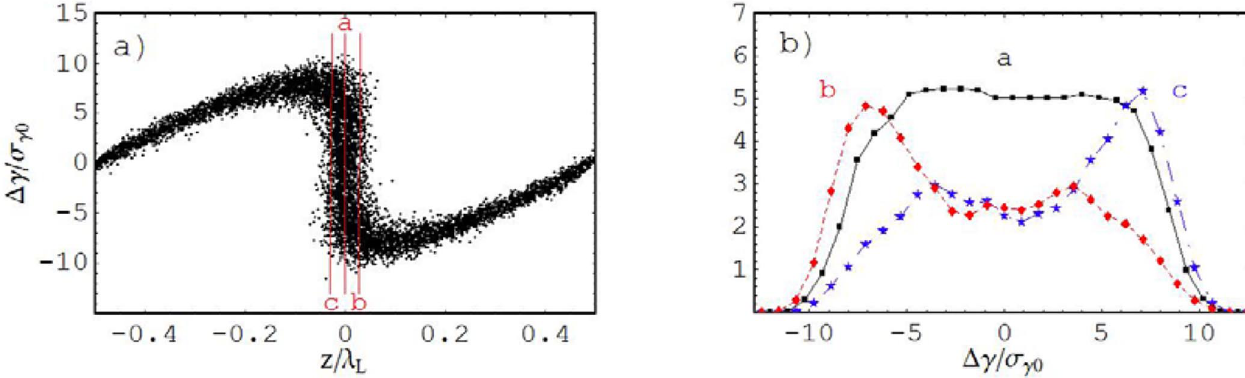
FIG. 2. (Color) (a) Longitudinal phase space after the chicane showing microbunching of electrons and an enhanced electron density. Only a part of the WS equivalent to one optical cycle at the laser wavelength is actually shown. (b) The histograms of the energy distribution of electrons after the chicane taken along the lines a; b; c in (a).